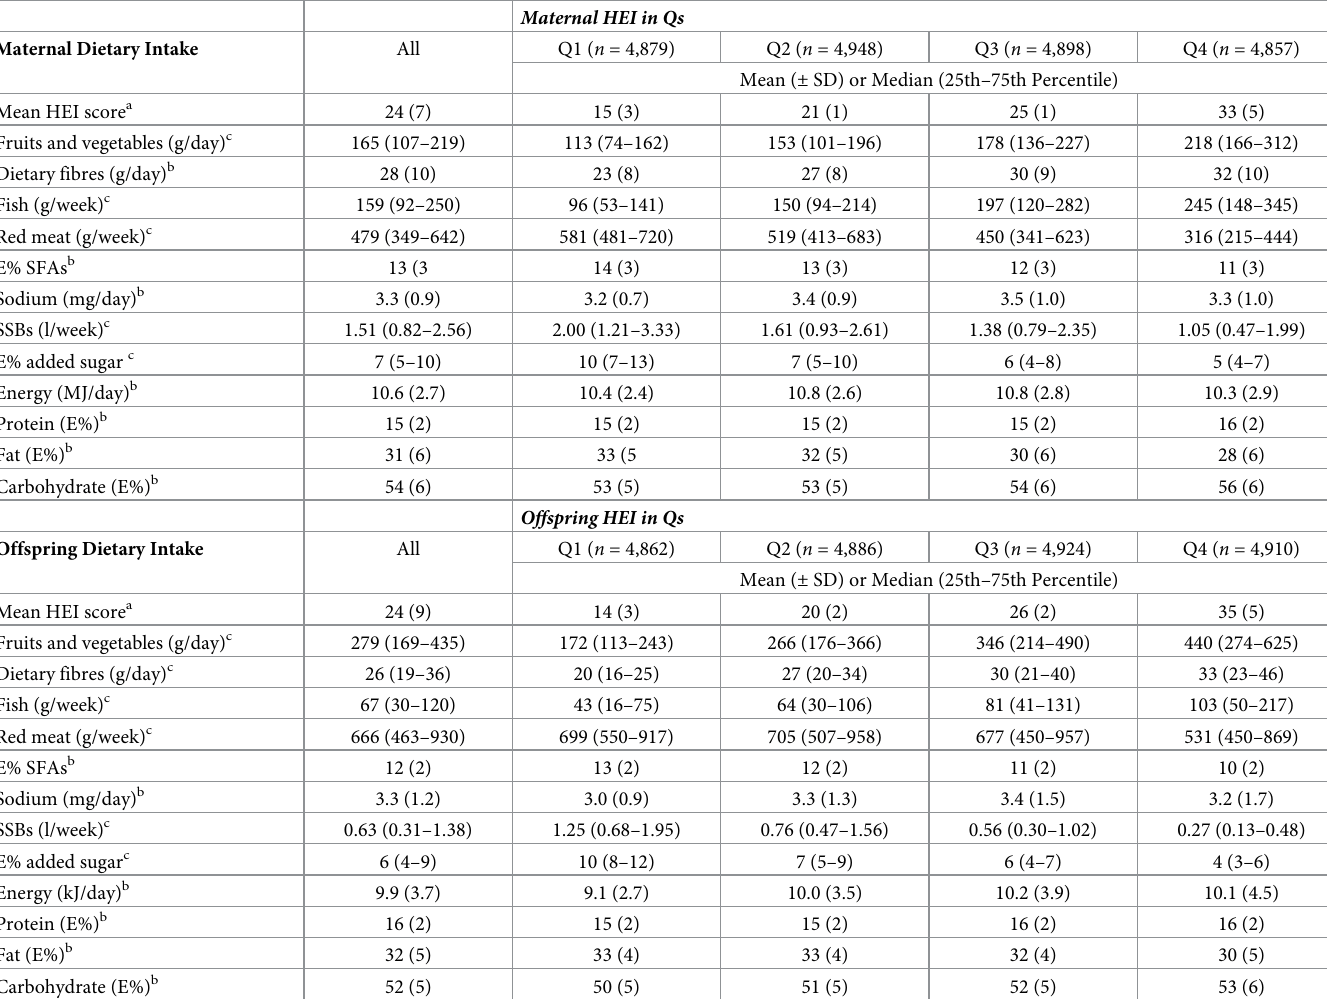
Table 3. Maternal pregnancy and offspring dietary habits according to HEI in Qs ( n =